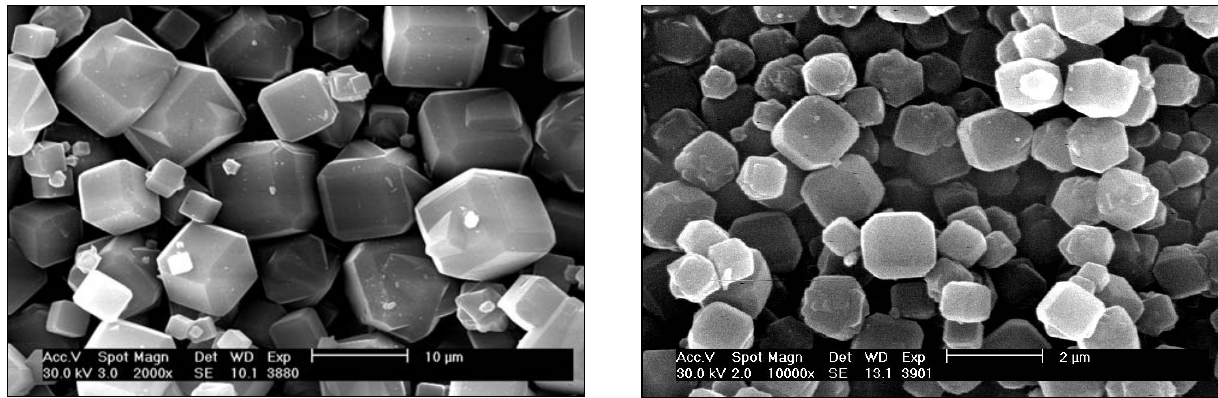
Figure 6. SEM micrographs of the zeolite A crystals obtained after transformation of the fresh gel (A) and gel aged for 209 h